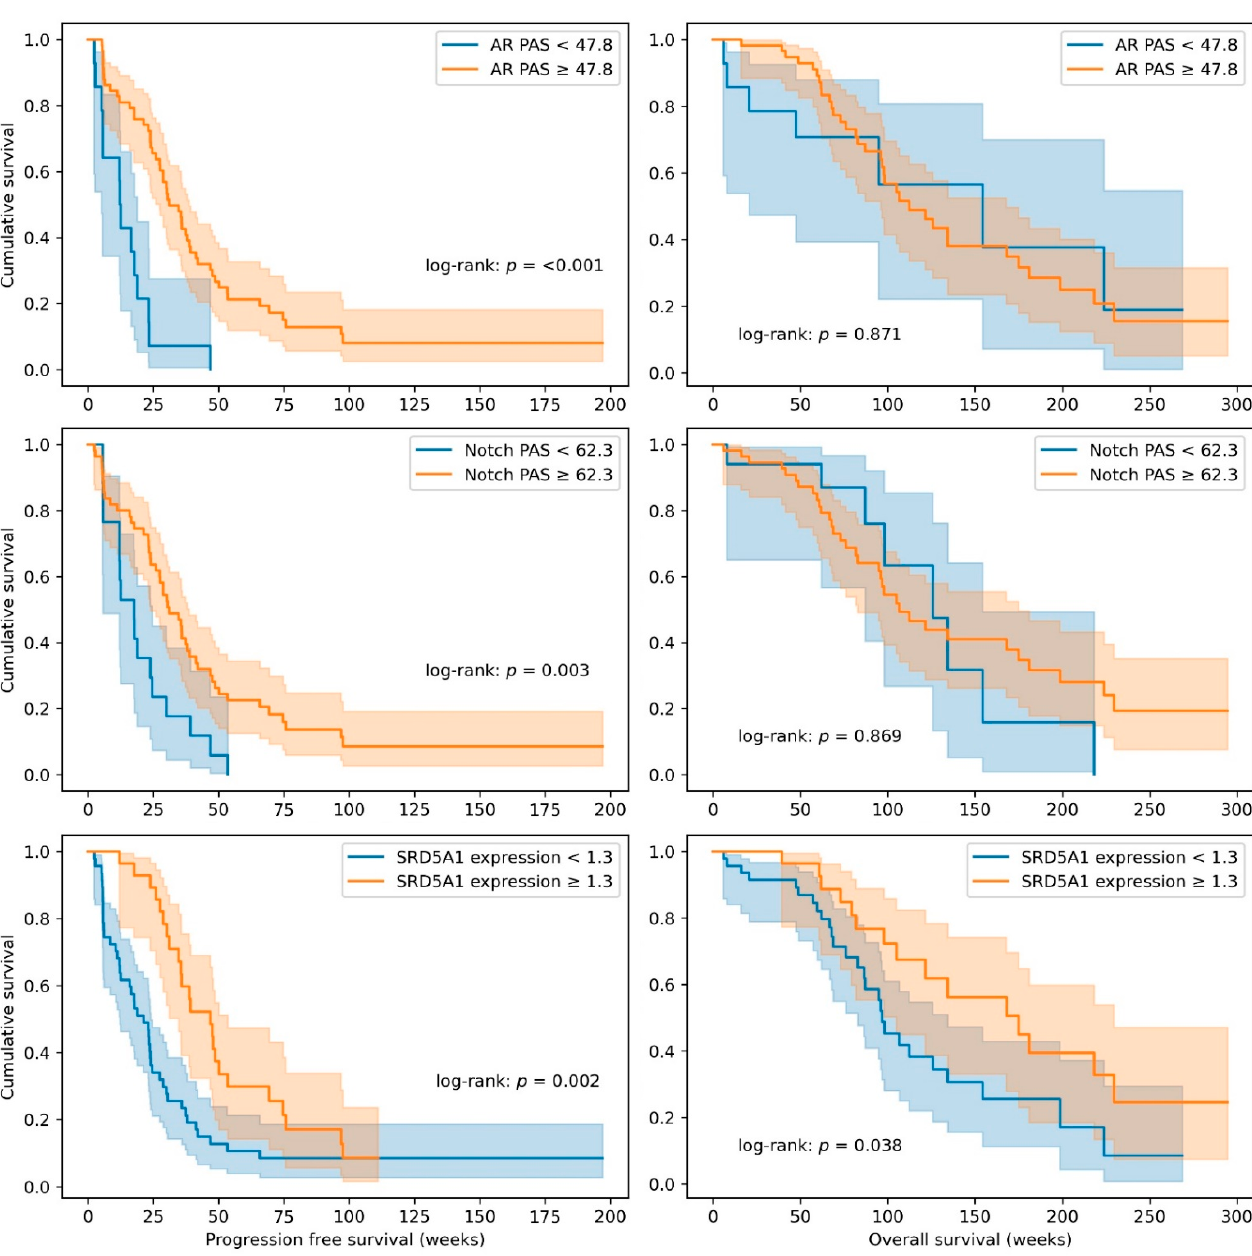
Figure 3. Kaplan–Meier curves of progression-free survival ( left ) and overall survival ( right ) for AR (androgen receptor) and Notch pathway activity scores (PAS) and SRD5A1 expression using cut-off values found in the ROC analysis.